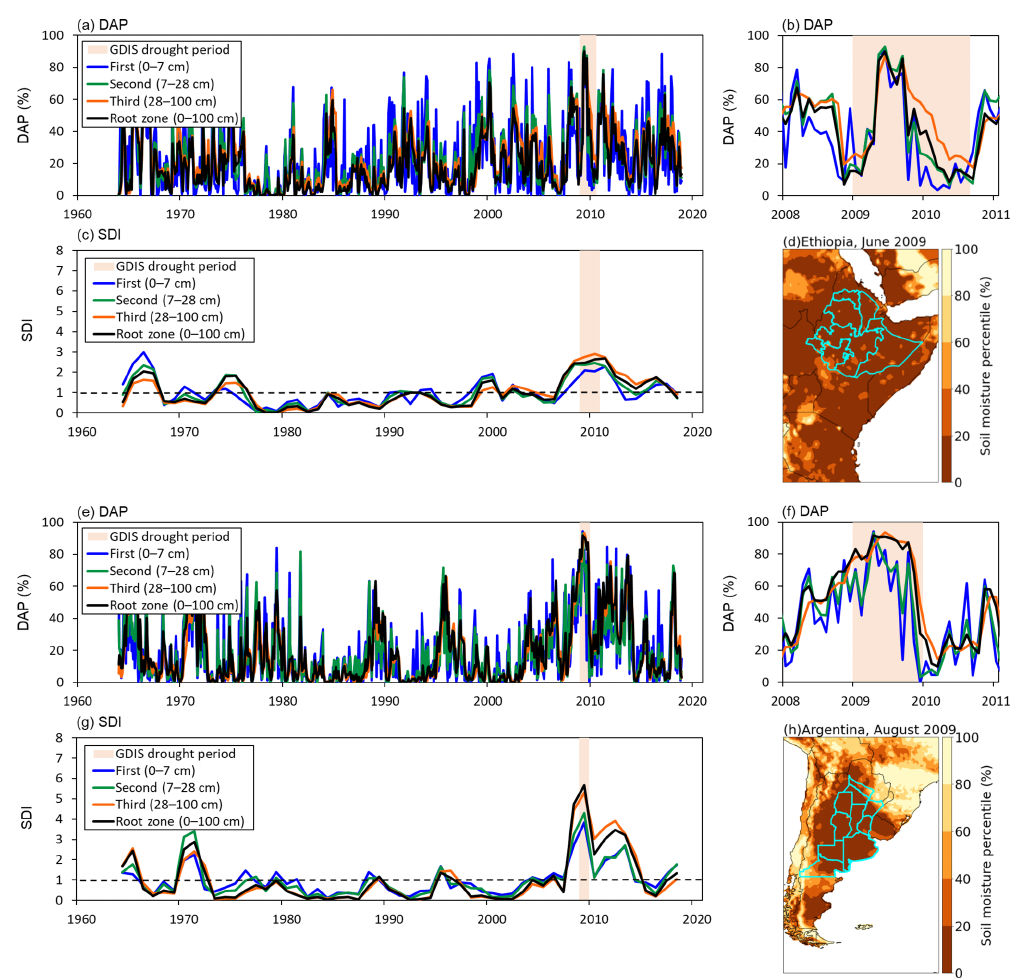
Figure 2. Demonstration of drought indices in different soil layers for the drought events in Ethiopia in 2009 (a–d) and Argentina in 2009 (e– h) . (a,e) DAP, where the red band shows the GDIS drought period and each coloured line shows the values in each soil layer (first – blue, second – green, third – orange, and root zone – black). (b,f) The enlarged view of DAP around the GDIS drought period. (c,g) SDI, where the legends are the same as DAP (a,e) , and the grey dotted line shows the value of 1 (the mean of SDI over the study period). (d,h) The GDIS drought area of this event, where the black line shows the country border, and the light blue line shows the affected administrative units shown in GDIS. GDIS provides GIS polygons of the administrative units, and administrative units with the same event identifier (disasterno) were treated as one GDIS event area, i.e. the assembly of each light blue administrative unit. The soil moisture percentile is generated from the root zone layer’s soil moisture, as an